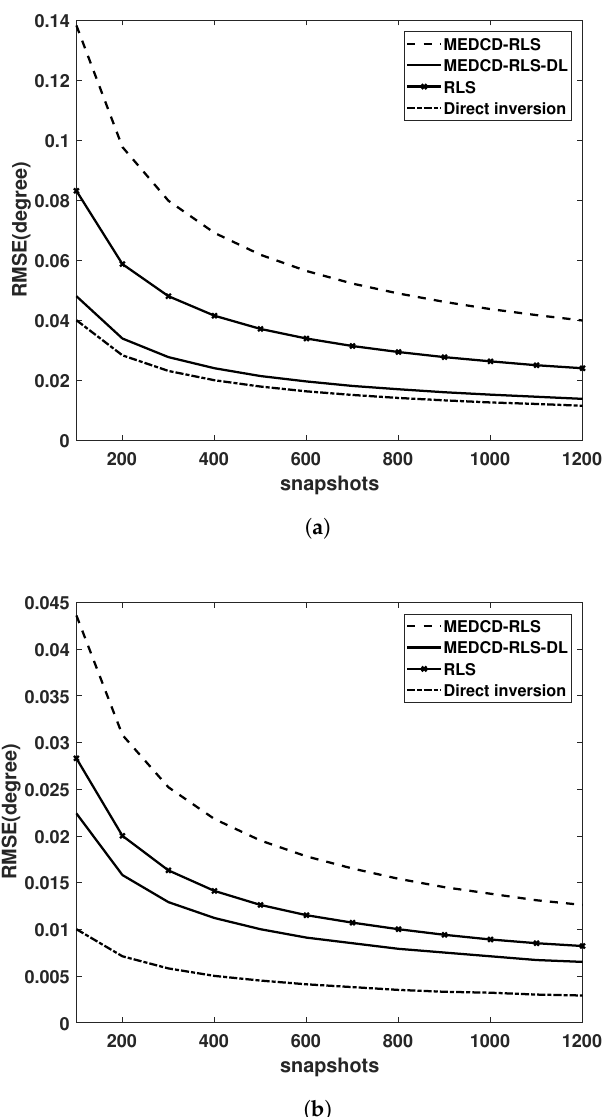
Figure 1. RMSE vs. snapshots with different SNRs; θ true = 30 ◦ . ( a ) SNR = 10 dB. ( b ) SNR = 20